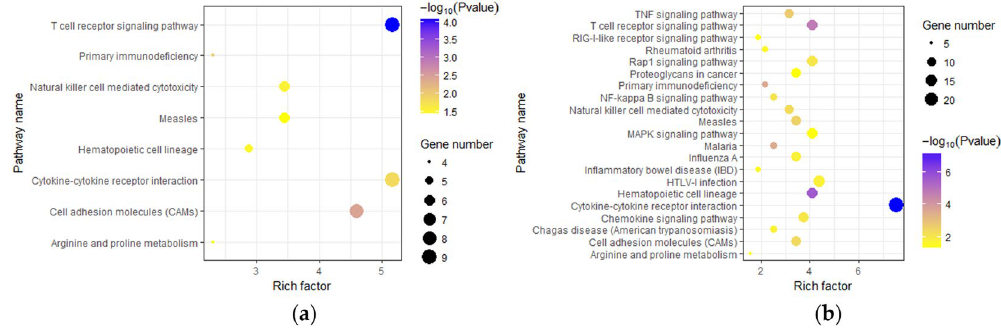
Figure 4. Enriched KEGG Pathway for targets of down-regulated DEmiRNAs responded to PRRSV. ( a ) downregulated miRNA in TC pigs; ( b ) downregulated miRNA in LW